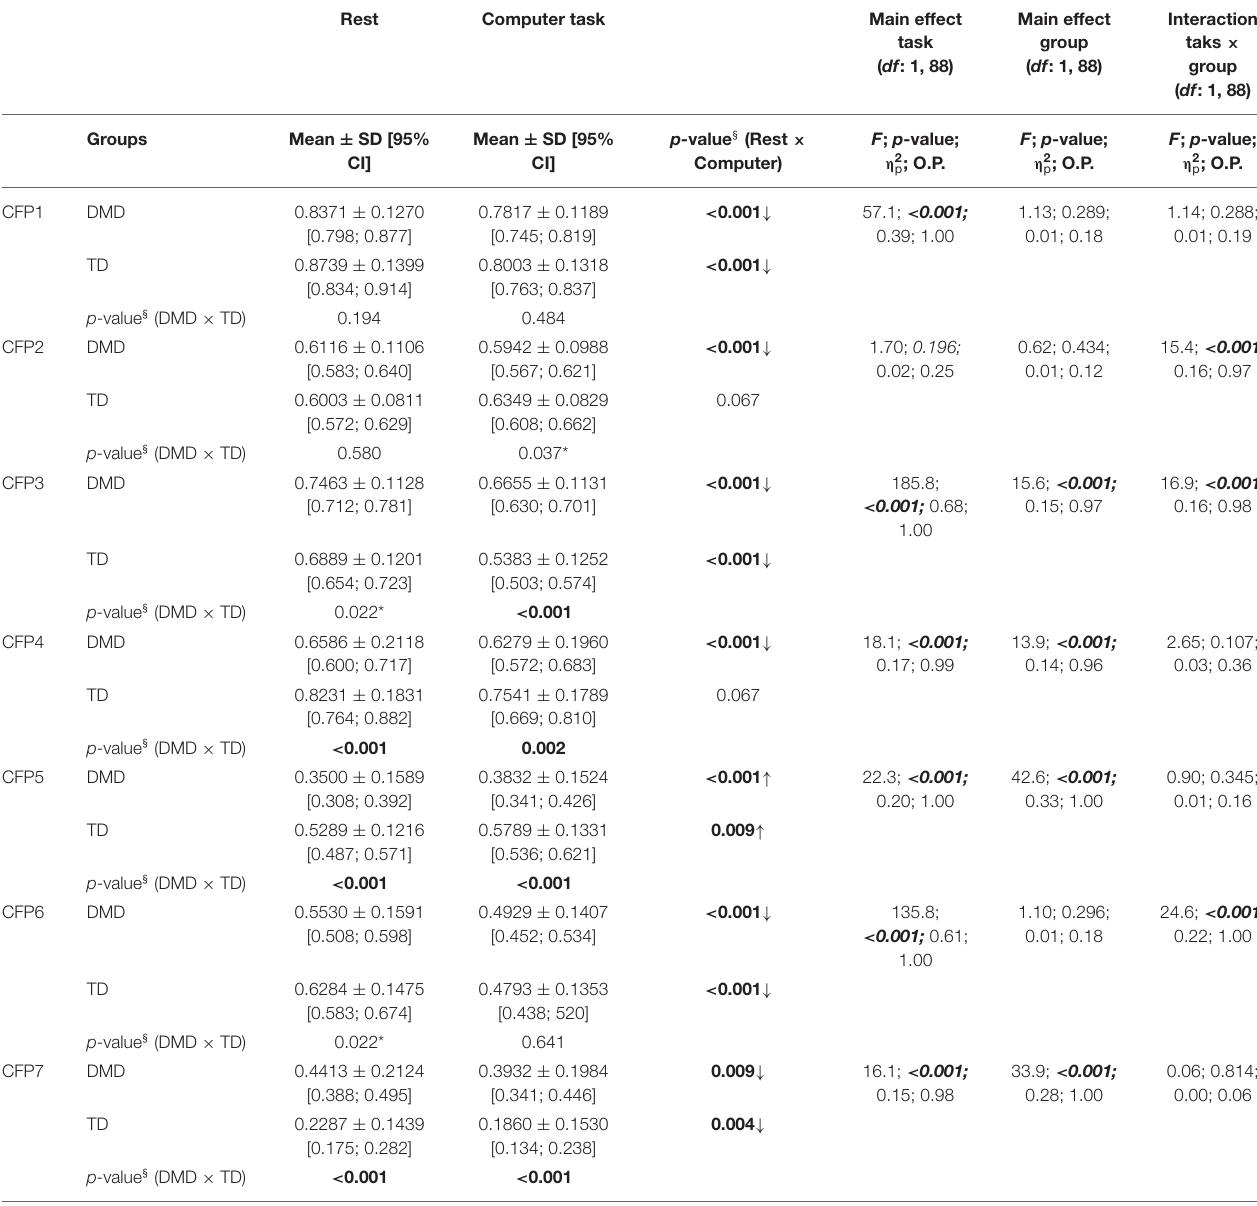
TABLE 5 | The table below demonstrates the results of a Repeated Measures-Multiple Analysis of Variance (RM-MANOVA), between Groups, within Tasks and its interactions, in addition to mean, stardard deviation, and confidence intervals for each